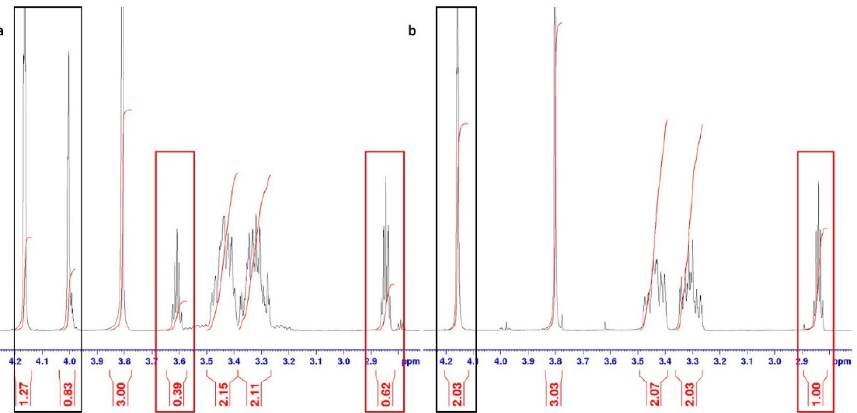
Figure 4. Part of the 1 H NMR spectrum showing ( a ) mixture of ( E / Z ) isomers of compound 1·HCl , and ( b ) pure ( E ) isomer of product 1·HCl . Red rectangles indicate the signals for the proton H4, and black rectangles the signals for the H2 protons of the quinuclidine ring.